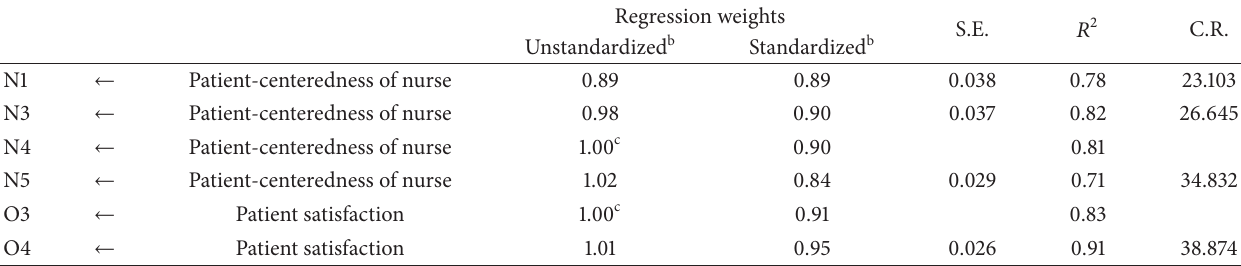
Table 2: Measurement model statistics a